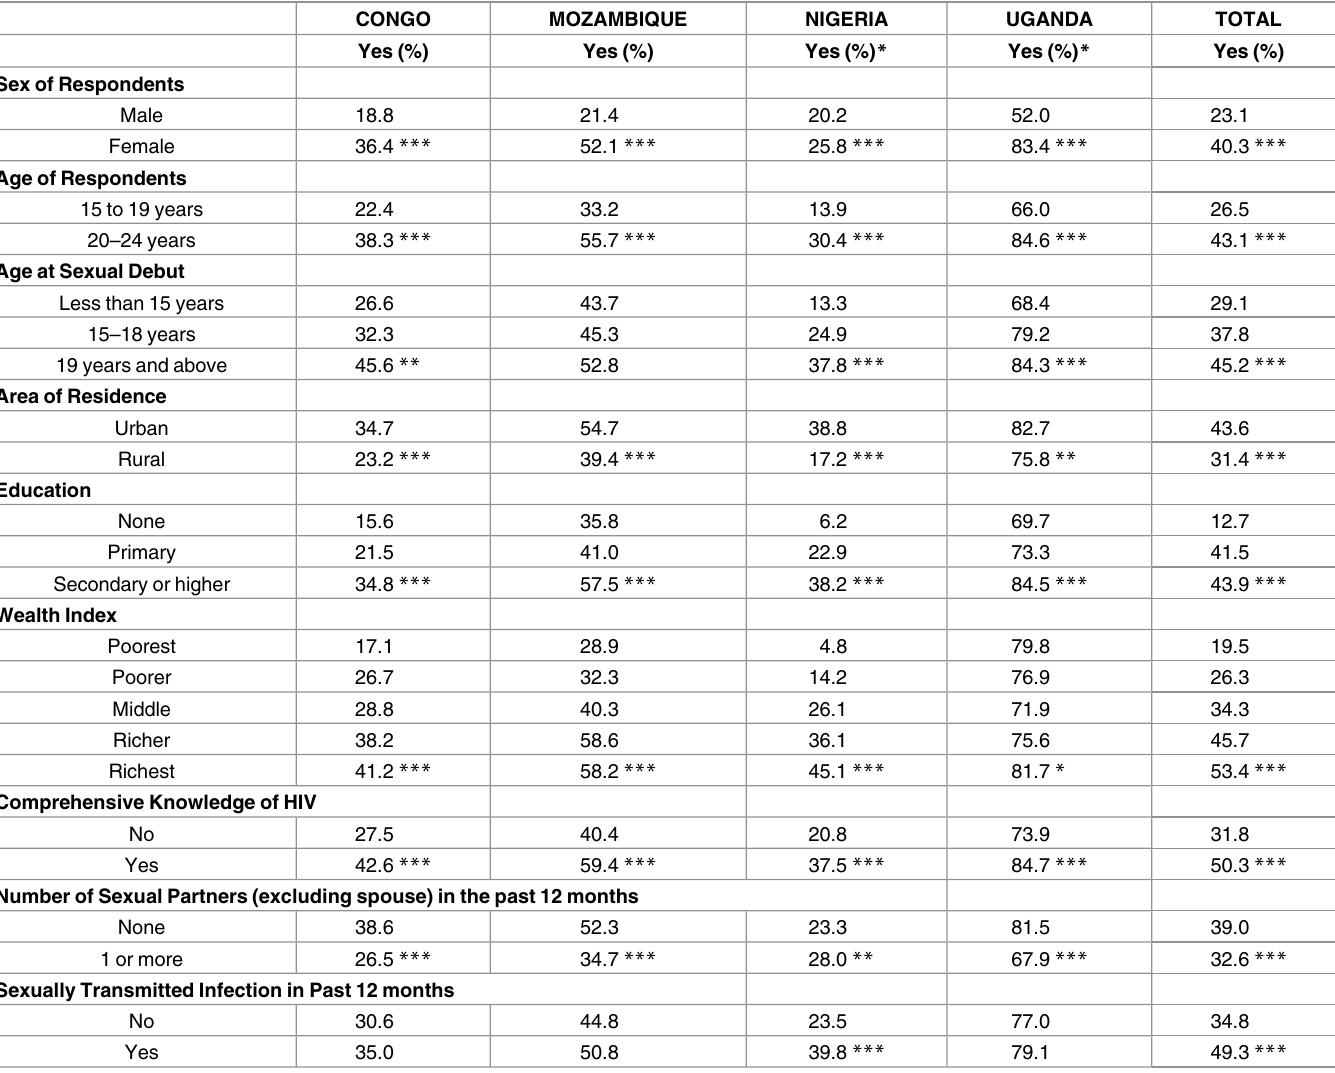
Table 2. Weighted Chi-square test of association between uptake of HIV testing and respondents’